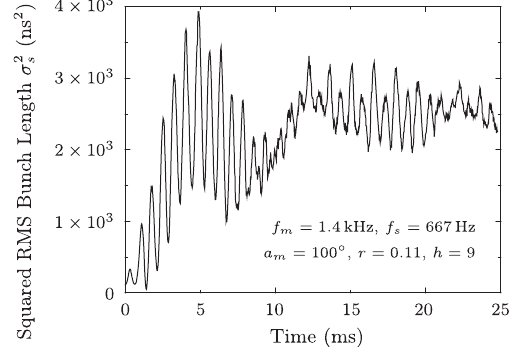
FIG. 1. Measurement of the squared rms bunch length σ 2 as a s function of time where the phase difference between the two rf ∼ 245 °. The data were obtained by digitizing cavities was Δ ϕ o beam position monitor signals at 1 ns resolution where phase ¼ 1 . 4 kHz and amplitude a ¼ 100 ° modulation of frequency f m m was applied to the higher-frequency cavity of a double rf system with rf voltage ratio r ¼ 0 . 11 and harmonic ratio h ¼ 9 . (The data is courtesy of D. Jeon et al.